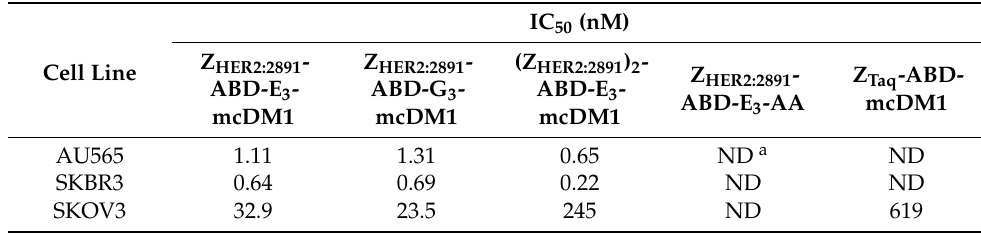
Table 3. In vitro cytotoxicity of the